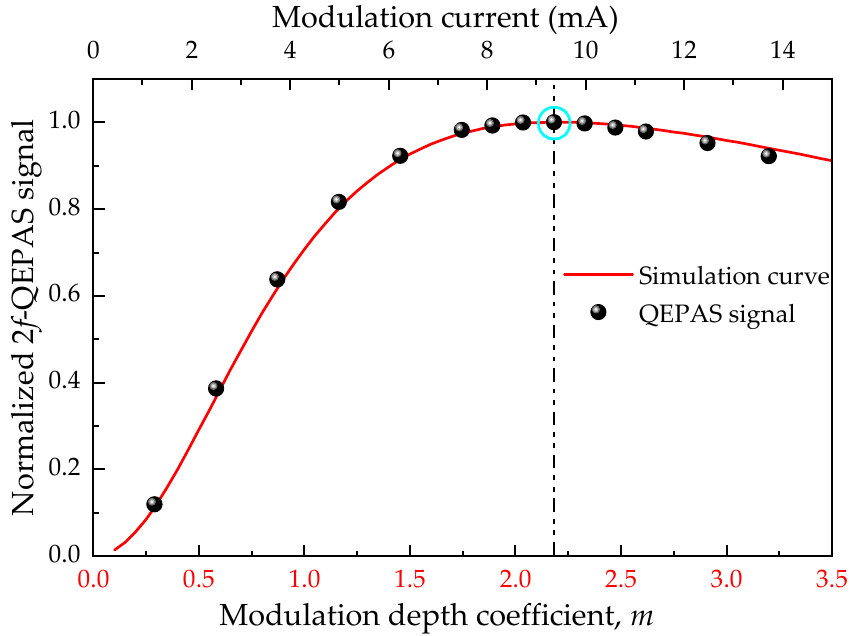
higher than 9.4 mA, no further increase can be observed. The QEPAS response is consistent with the simulation result plotted as a red line and the optimized modulation current corresponds to a wavelength modulation depth coefficient of 2.2.